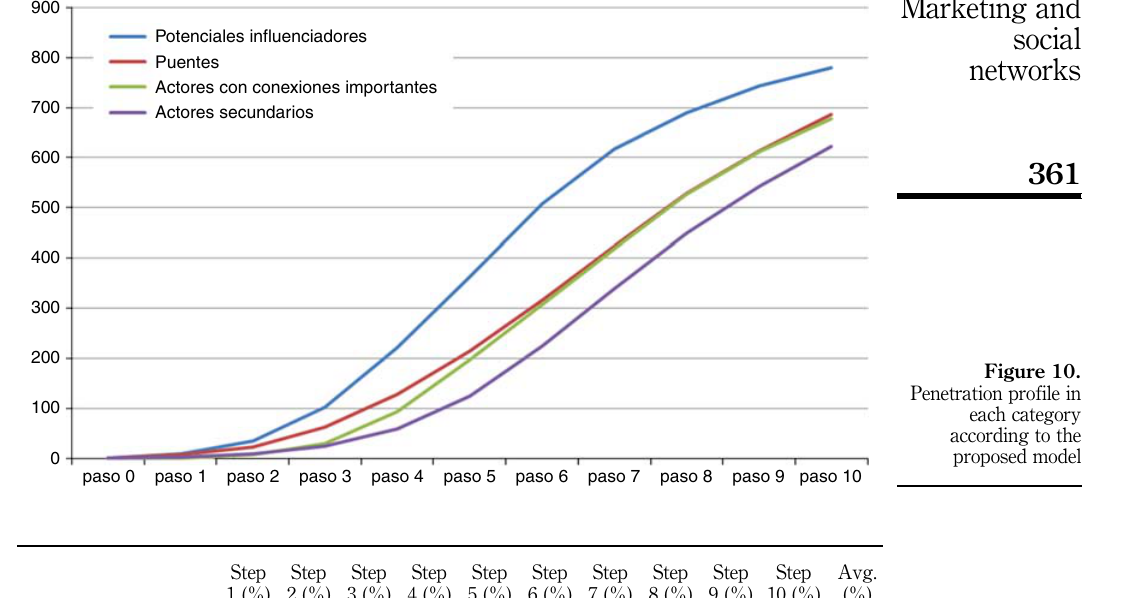
Table V. Diffusion reach